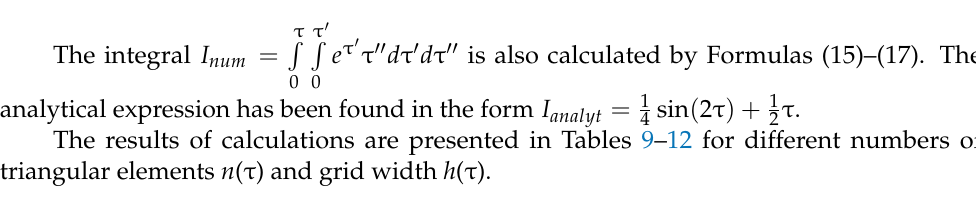
Table 9. Calculation of integral